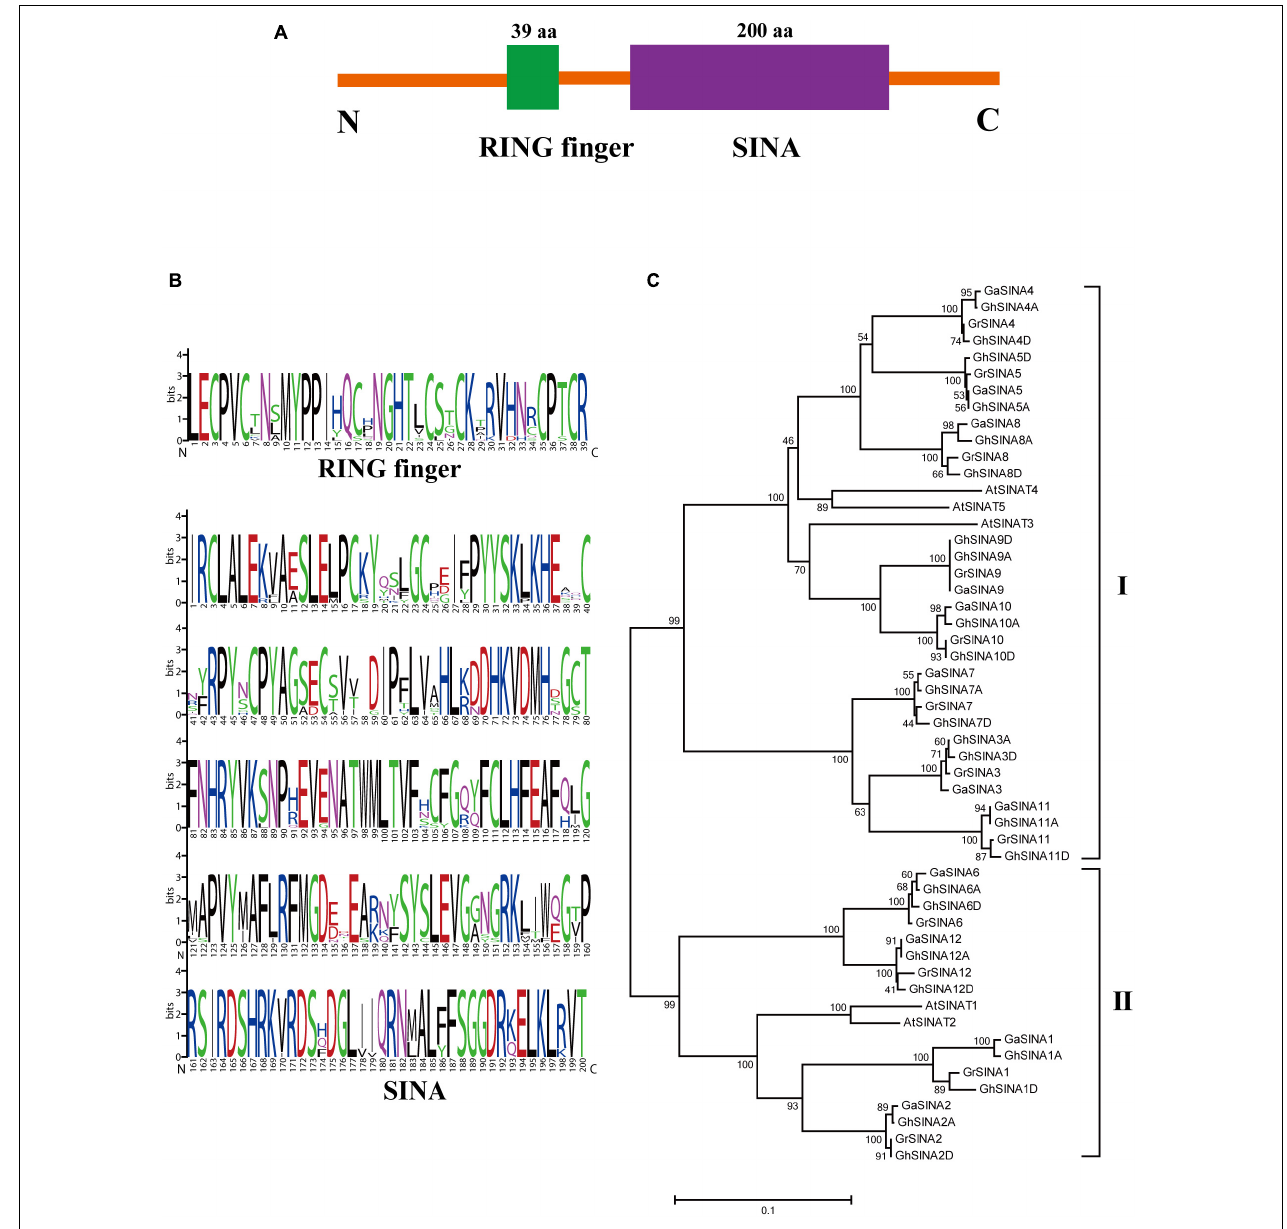
FIGURE 1 | Conserved domain and phylogenetic analyses of SINA ubiquitin ligases in cotton. (A) Members of the SINA gene family are characterized by two highly conserved domains: a RING finger domain toward the N-terminal and a SINA domain toward the C-terminal. (B) Sequence logos showing the highly conserved RING finger and SINA domains in G. hirsutum SINA ubiquitin ligases. (C) Phylogenetic analysis of SINA ubiquitin ligases in G. arboreum , G. raimondii , G. hirsutum and Arabidopsis. The unrooted phylogenetic tree was generated with MEGA 7.0 using the neighbor-joining method with 1,000 bootstrap replicates. Numbers on the tree branches represent bootstrap